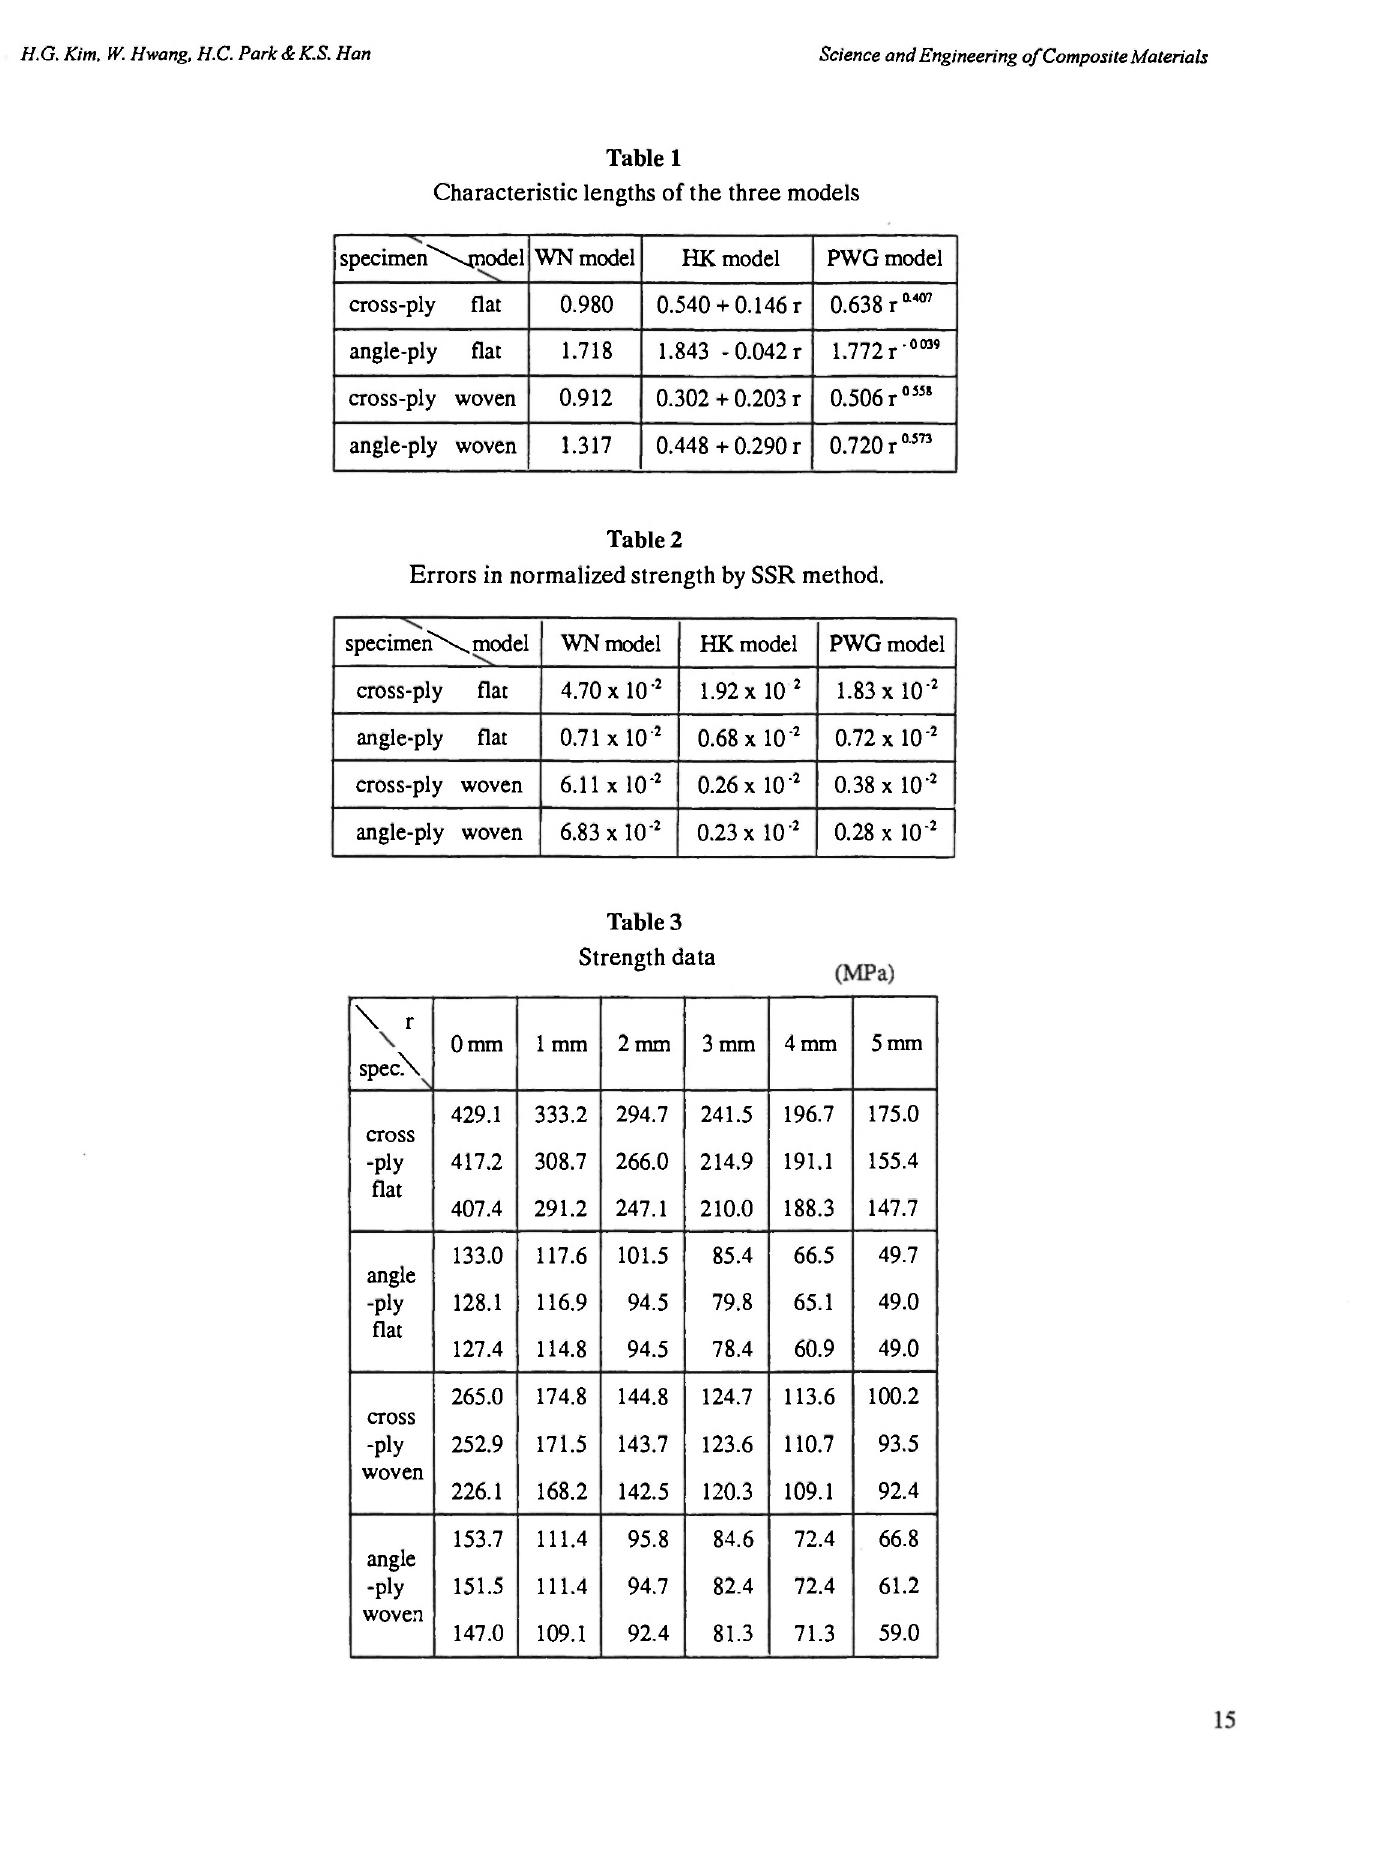
Characteristic lengths of the three models